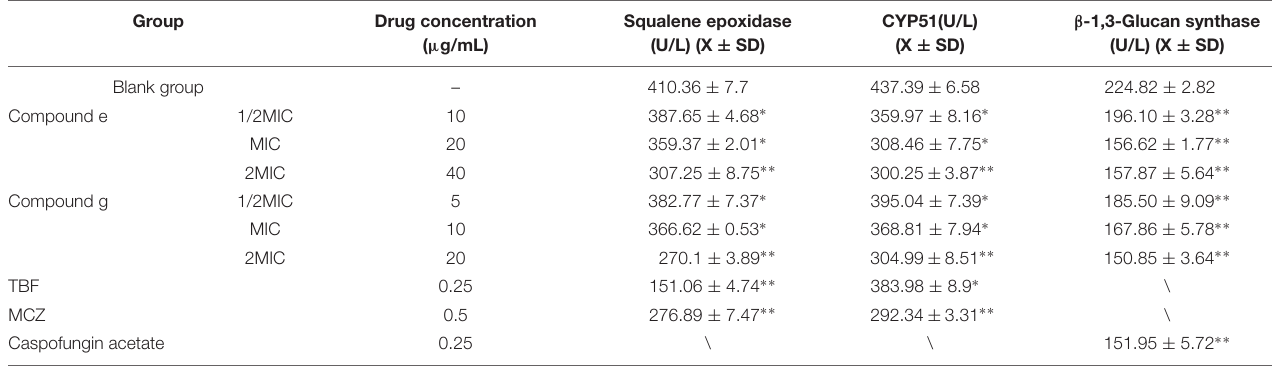
TABLE 3 | Effect of compounds e and g on squalene epoxidase, CYP51, and β -1,3-glucan synthase. Group